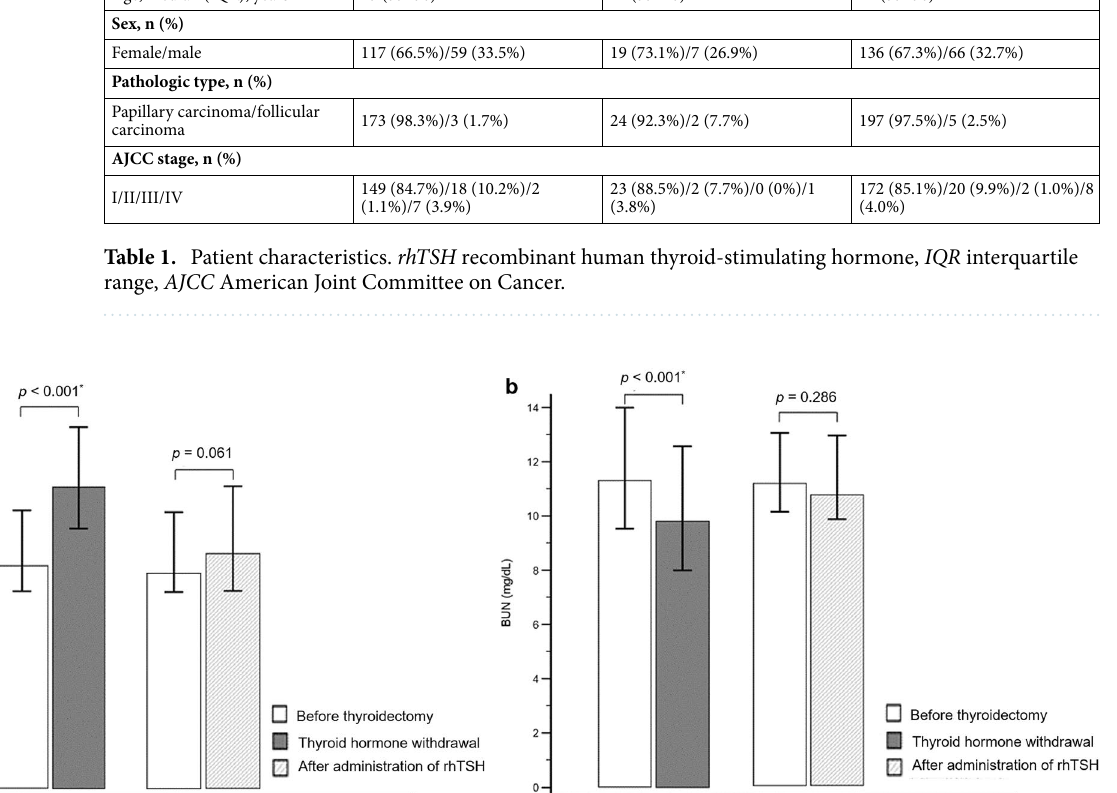
Thyroid hormone withdrawal ( n = 176)